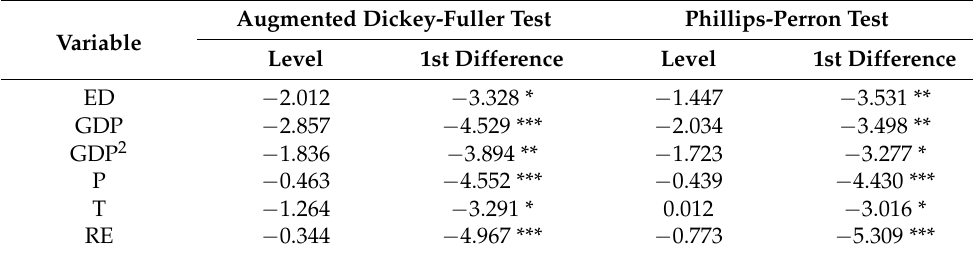
Table 2. Results of Unit Root